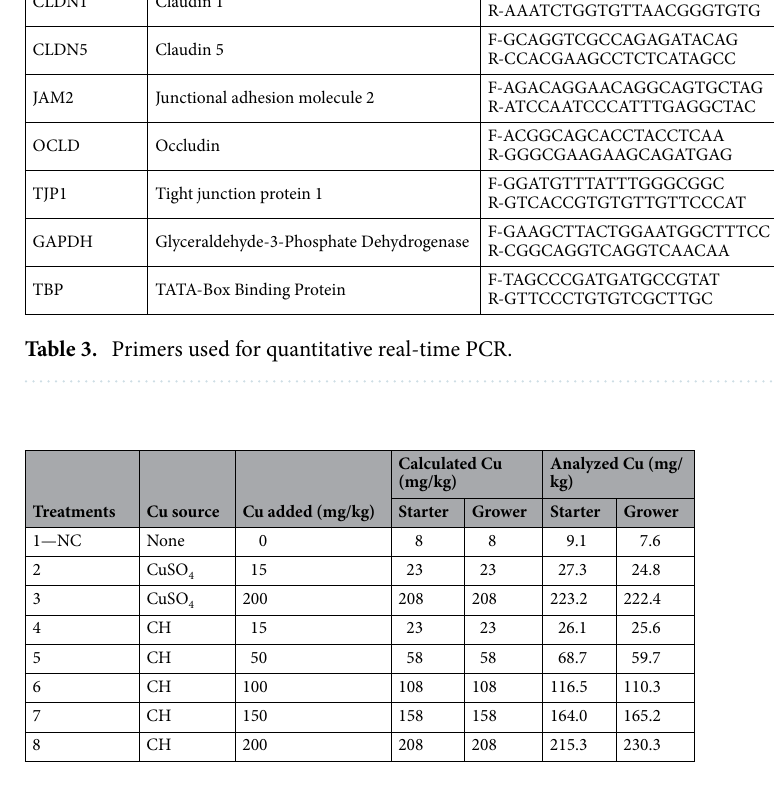
Table 4. The analyzed Cu concentration in the dietary treatments. Values based on chemical analysis of duplicate samples of diets and reported on an as-fed basis. NC Negative control, no added Cu; CH Copper hydroxychloride (Intellibond